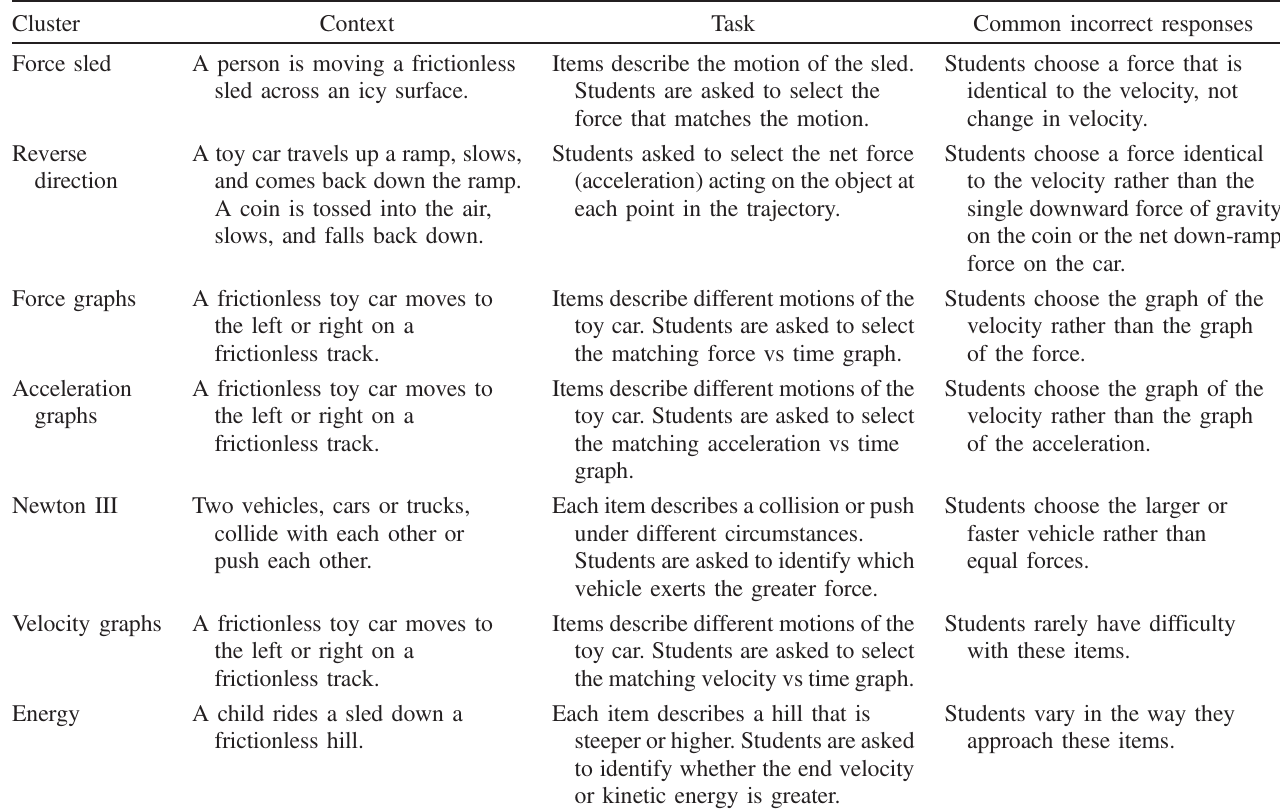
TABLE I. Description of items in clusters.